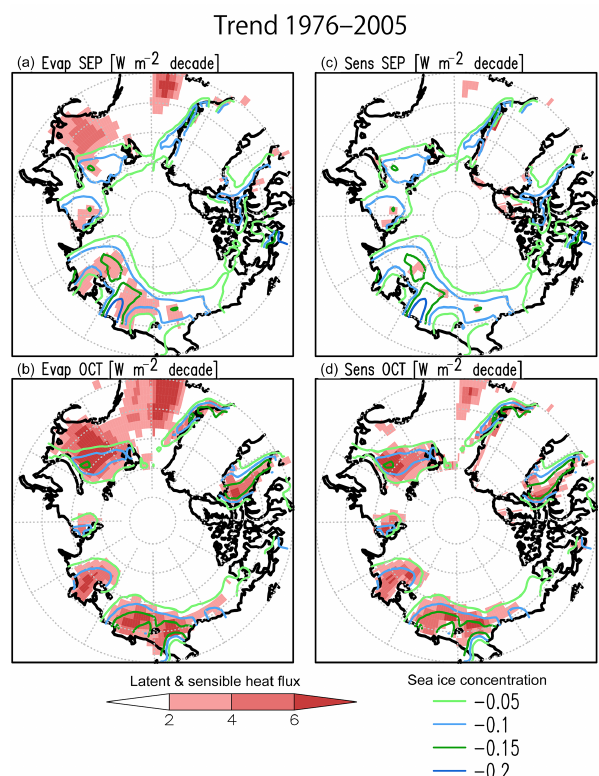
Figure 7. Geographical map of the simulated linear trend in (a, b) latent heat and (c, d) sensible heat fluxes in (a, c) September and (b, d) October during the period 1976–2005. The units are Wm − 2 decade − 1 . A linear trend for the sea ice concentration (con- tours) is overlaid, and the units are decade − 1